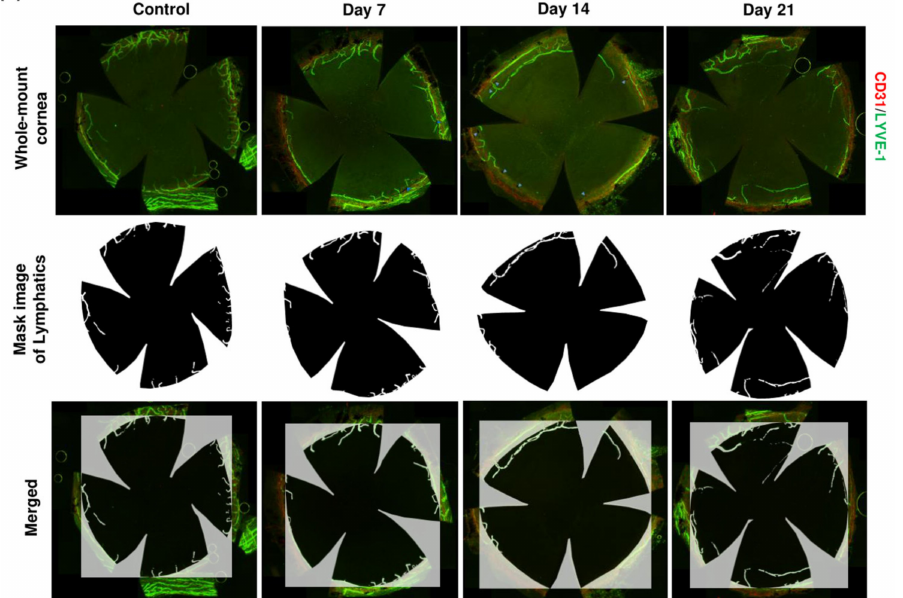
Figure 5. Lymphangiogenesis induced in the originally avascular cornea by housing mice under desiccating conditions. Representative immunofluorescence images of whole-mount cornea of the control group and dry eye group on days 7, 14, and 21 of dry eye induction in a controlled environmental chamber (upper set), the mask image of lymphatics automatically generated by the custom-designed macro of ImageJ (middle set), and merged whole-mount and mask images (lower set). The boundary of the cornea was decided considering the pigments (blue arrowheads), which were left at the place where the iris and ciliary body were attached. Corneas were immunostained with CD31 (red) and LYVE-1 (green) antibodies. (Courtesy of Lee et al., Ocul Surf. 2021 Jul 24;22:72–79. under the terms of the Creative Commons CC-BY license, Ref.